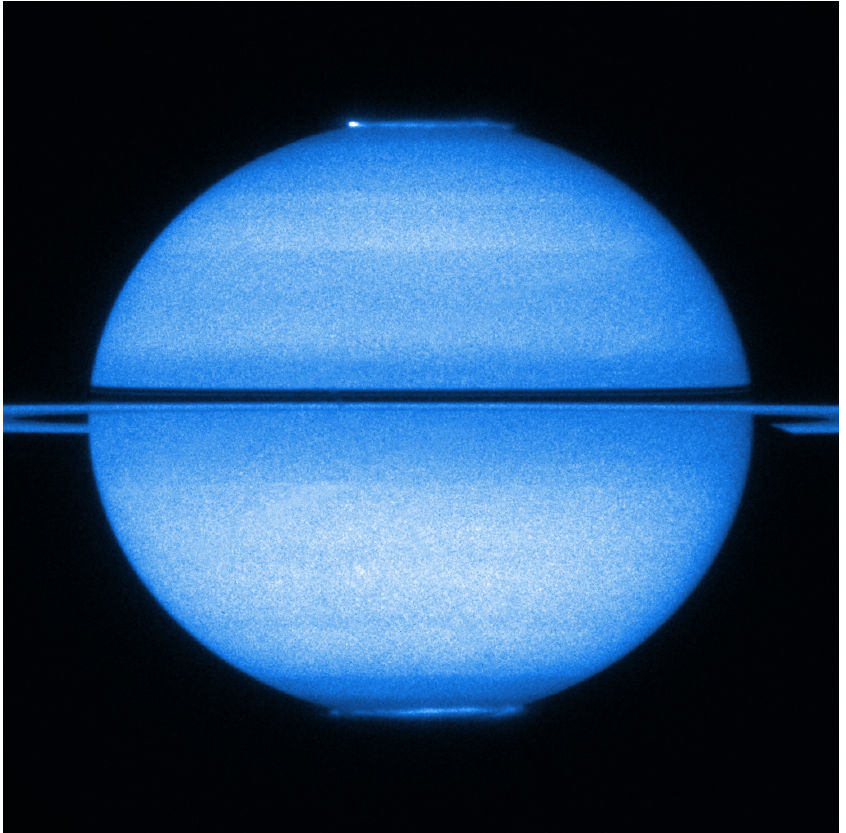
Figure 7. Saturn at equinox, taken by the Hubble Space Telescope in 2009. Saturn’s rings are seen edge-on and both poles are in view, offering a simultaneous view of both aurorae. Figure from the associated press release of [76]. Credit: NASA, ESA and Jonathan Nichols (University of